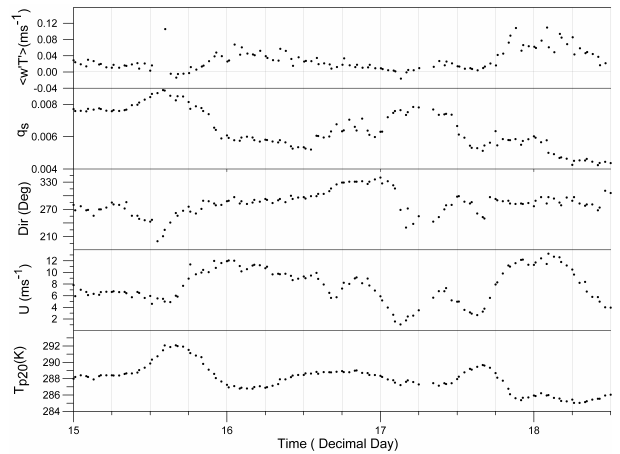
Fig. 2. Time series recorded by the mast between 15 and 18 June 1992. From top to bottom: the sensible heat flux at the surface h w 0 T 0 i (2mt); specific humidity (gkg − 1 ), wind direction DIR, wind speed U , potential temperature T p20 , all recorded at the height h =